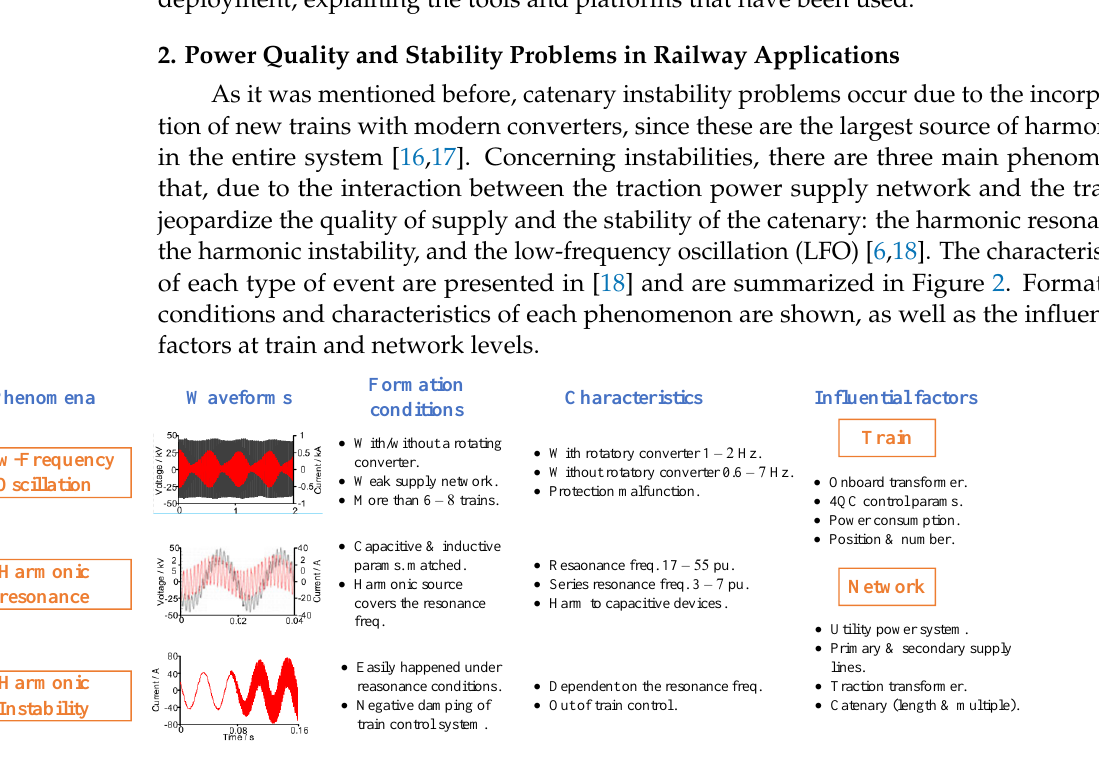
Figure 2 . Main characteristics of the most common AC catenary instability phenomena: LFO, harmonic resonance, and harmonic instability [18.]